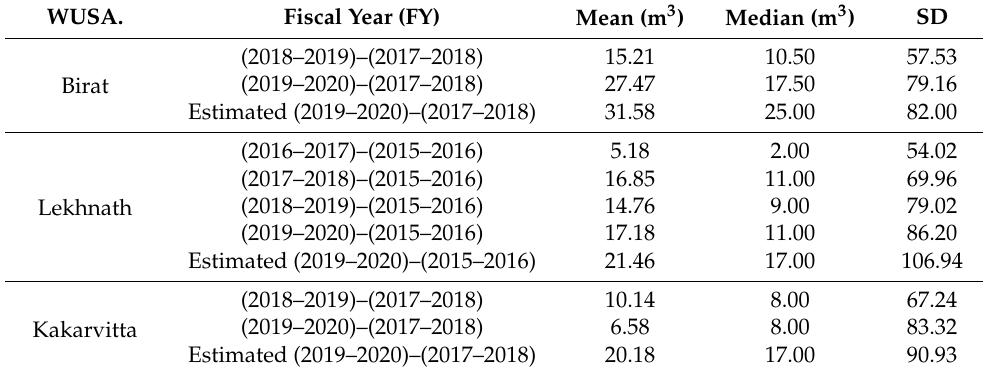
Figure 7. Multiple-year water consumption variation: ( a ) Birat, ( b ) Lekhnath, and ( c ) Kakarvitta. Table 5. Variation in mean, median and standard deviation (SD) in